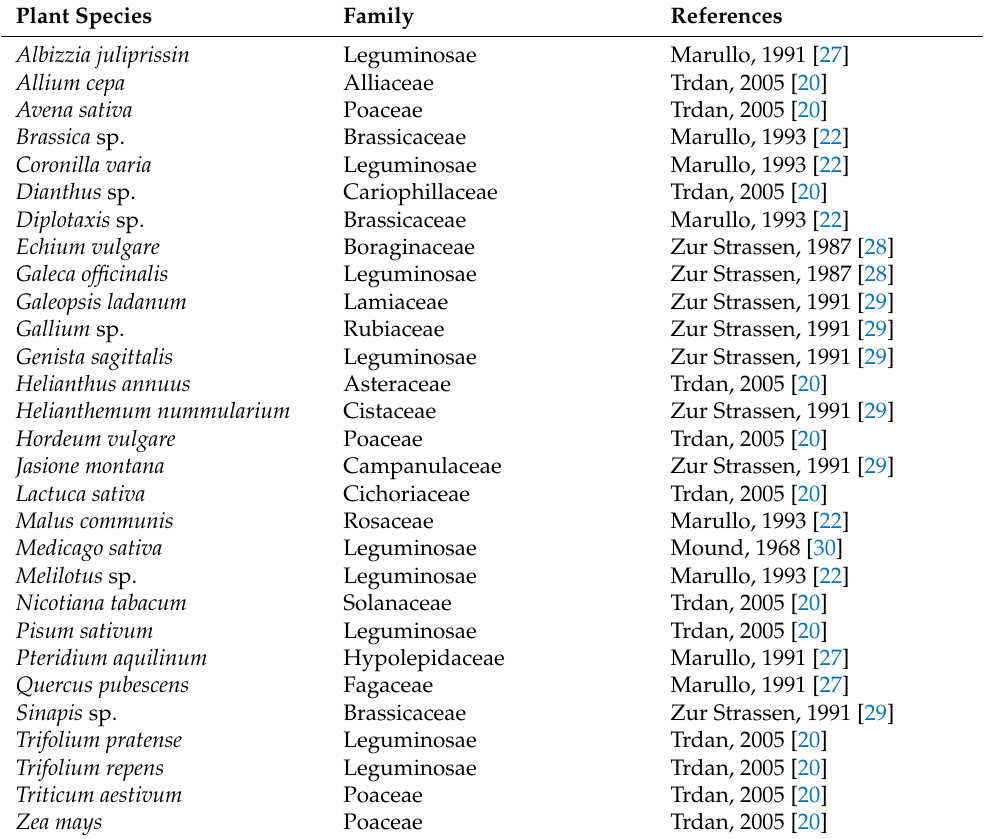
Table 1. Plant species for which the predatory thrips Aeolothrips intermedius have been